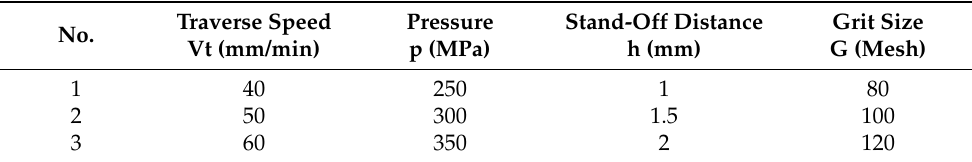
Table 1. Configuration of the input parameter (factor) set-points.